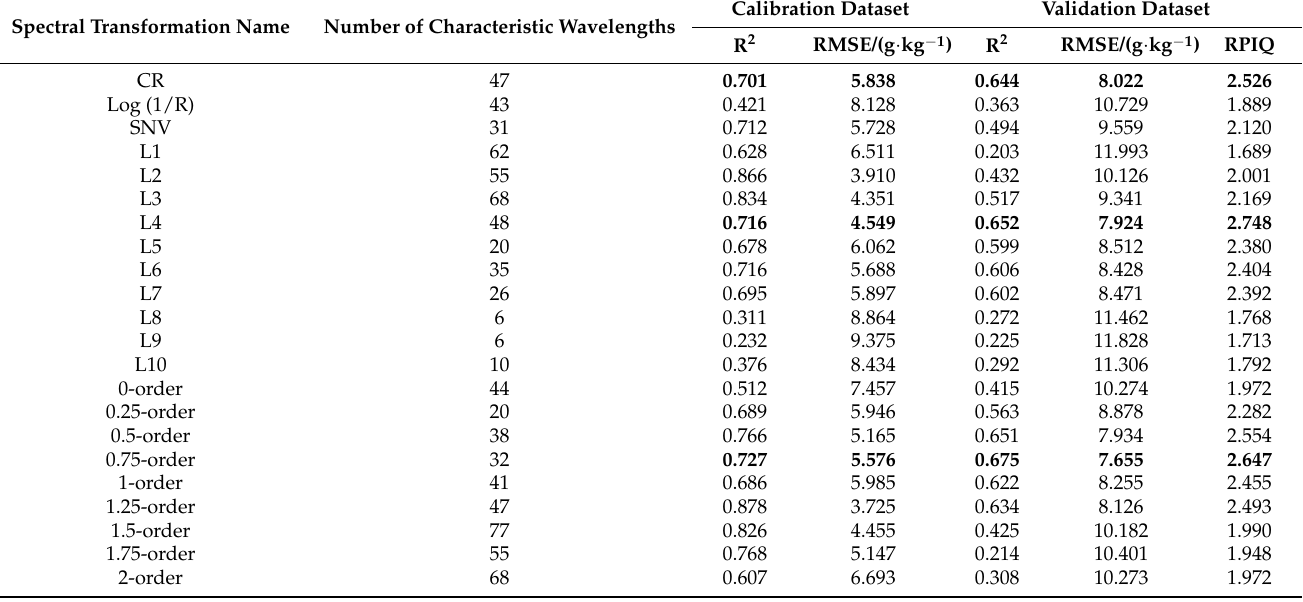
Table 8. The results of the SVR estimation of soil iron oxide content using characteristic